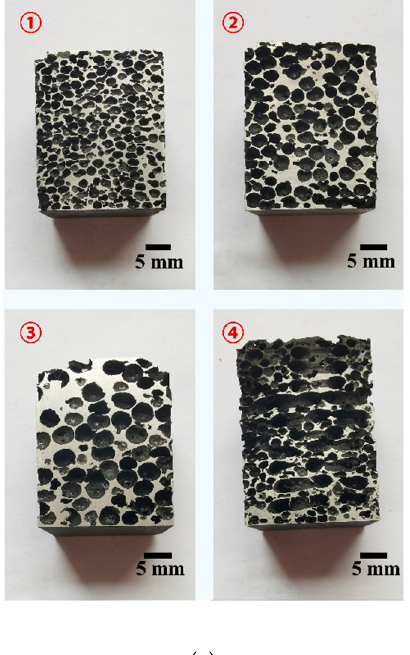
Figure 4. Water bath condition of copper foam preform, ( a ) the electrolytic copper preform, ( b ) the